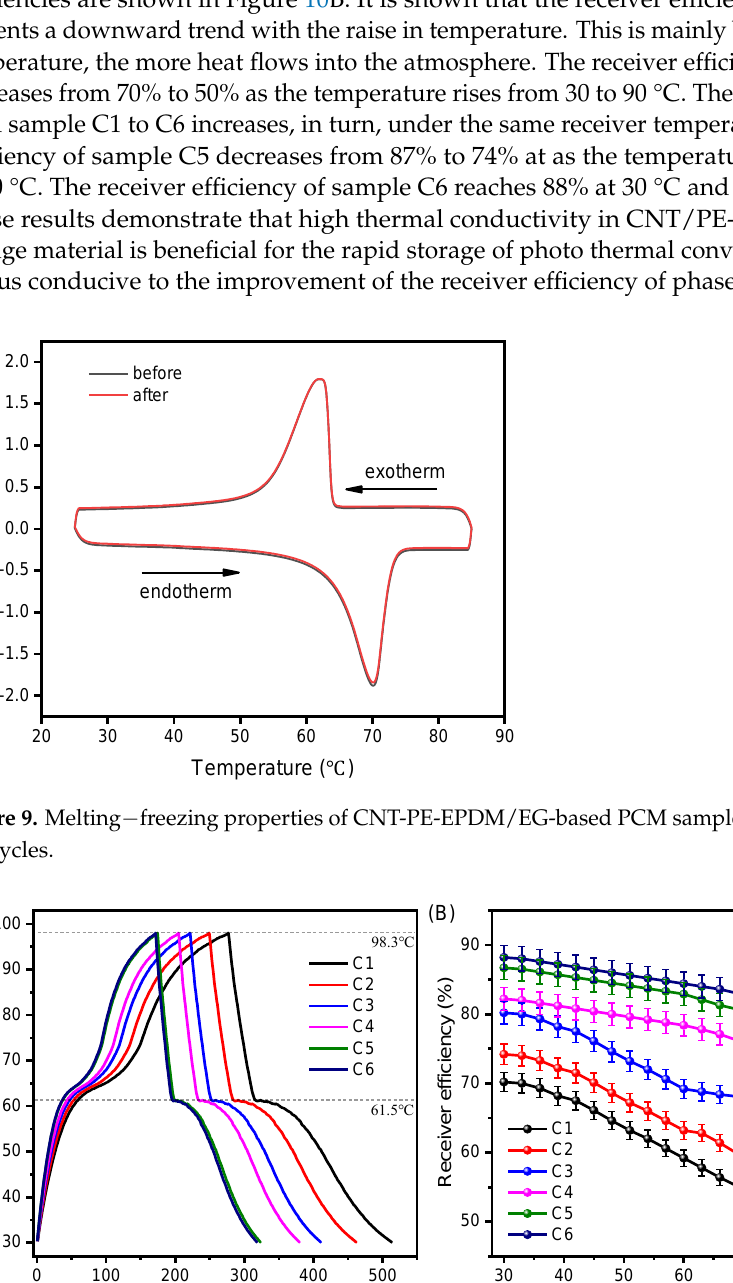
Figure 10. Photo-thermal performance ( A ) and receiver efficiency ( B ) the as-prepared CNT-PE- EPDM/EG-based PCM samples